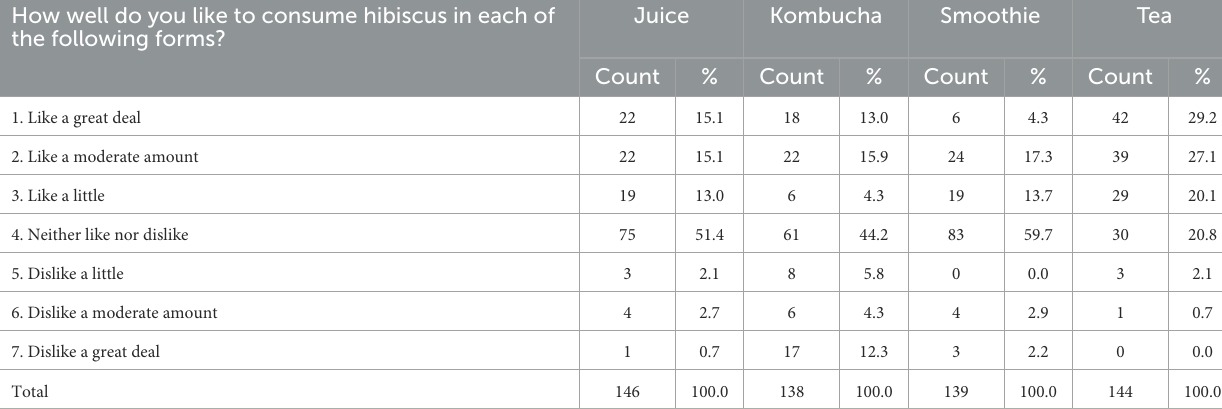
TABLE 2 Likability of hibiscus beverages: Juices, kombuchas, smoothies, and